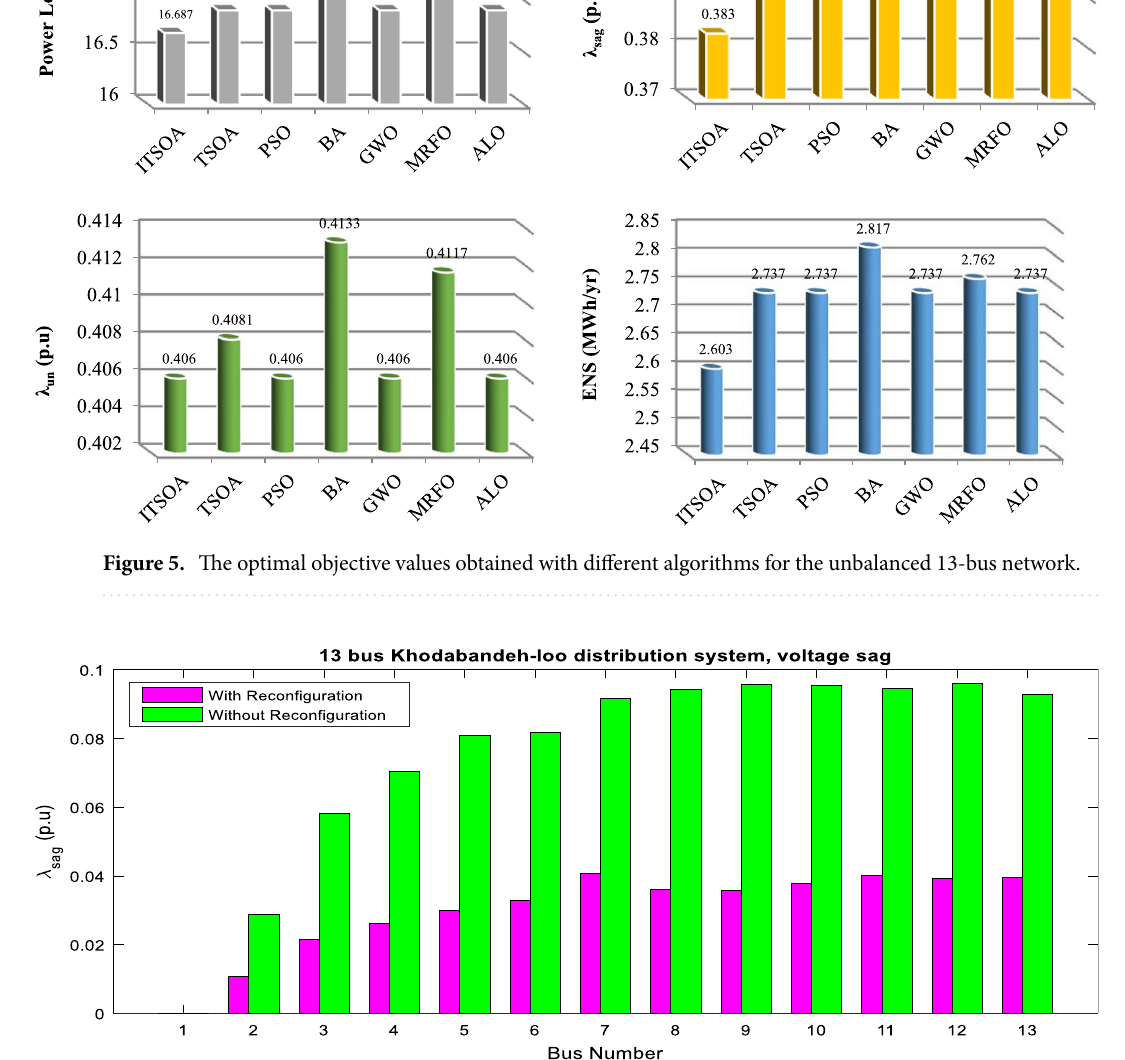
Figure 6. Voltage sag of 13-bus network via ITSOA with and without reconfiguration.